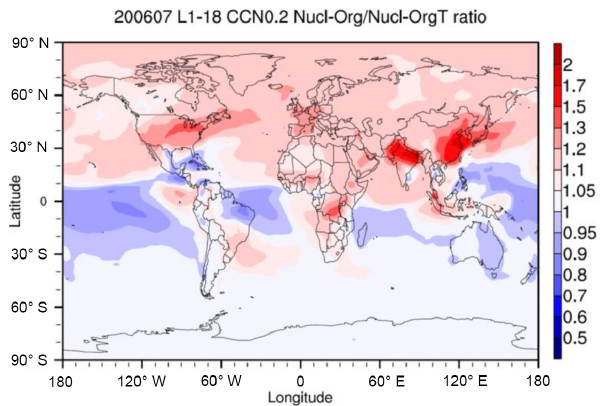
Figure 8. The ratios of the concentration of CCN (at a water super- saturation ratio of 0.2%) in the lower troposphere (0–3km) based on the Nucl-Org scheme to those based on the Nucl-OrgT